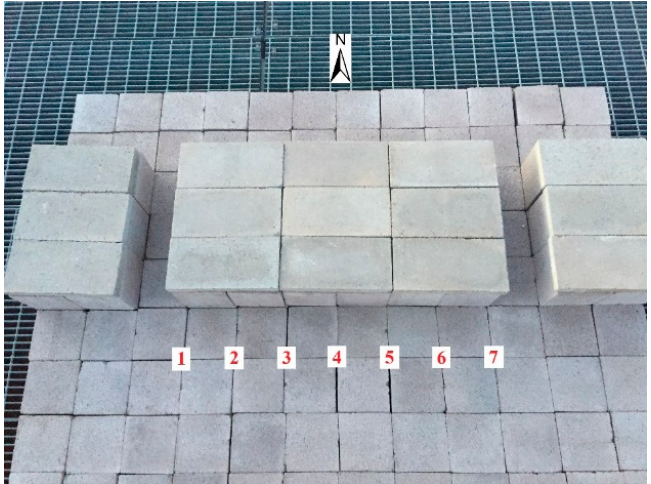
Figure 3. Potential tree locations in the outdoor urban physical scale model. Table 2. Summary of tree number, location, and arrangement in different experimental groups. Group No.